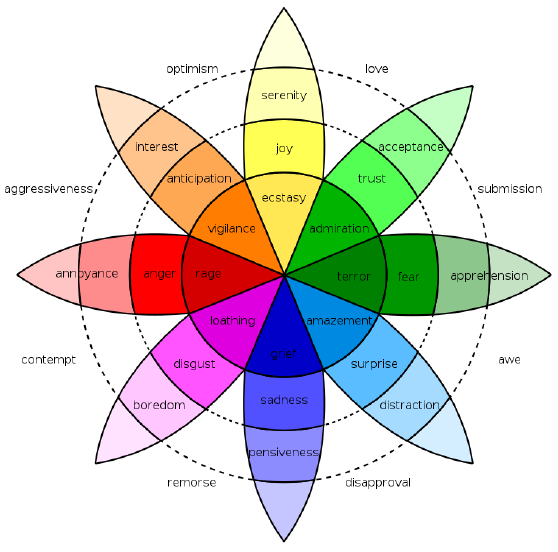
Figure 1. Plutchik’s wheel of emotions. As provided by Machine Elf 1735 - Own work, Public